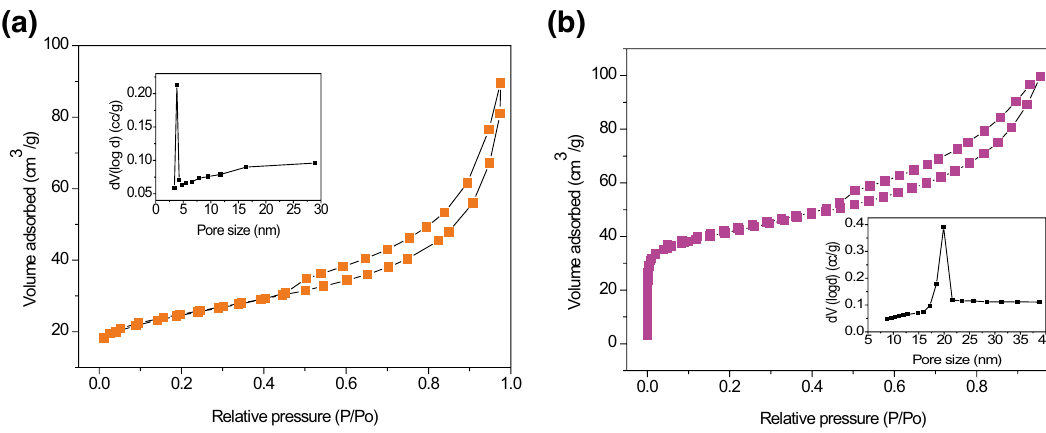
Figure 3. BJH nitrogen adsorption–desorption isotherms of raw sepiolite ( a ), and NiO/sepiolite ( b ), the inset are the corresponding pore size distribution